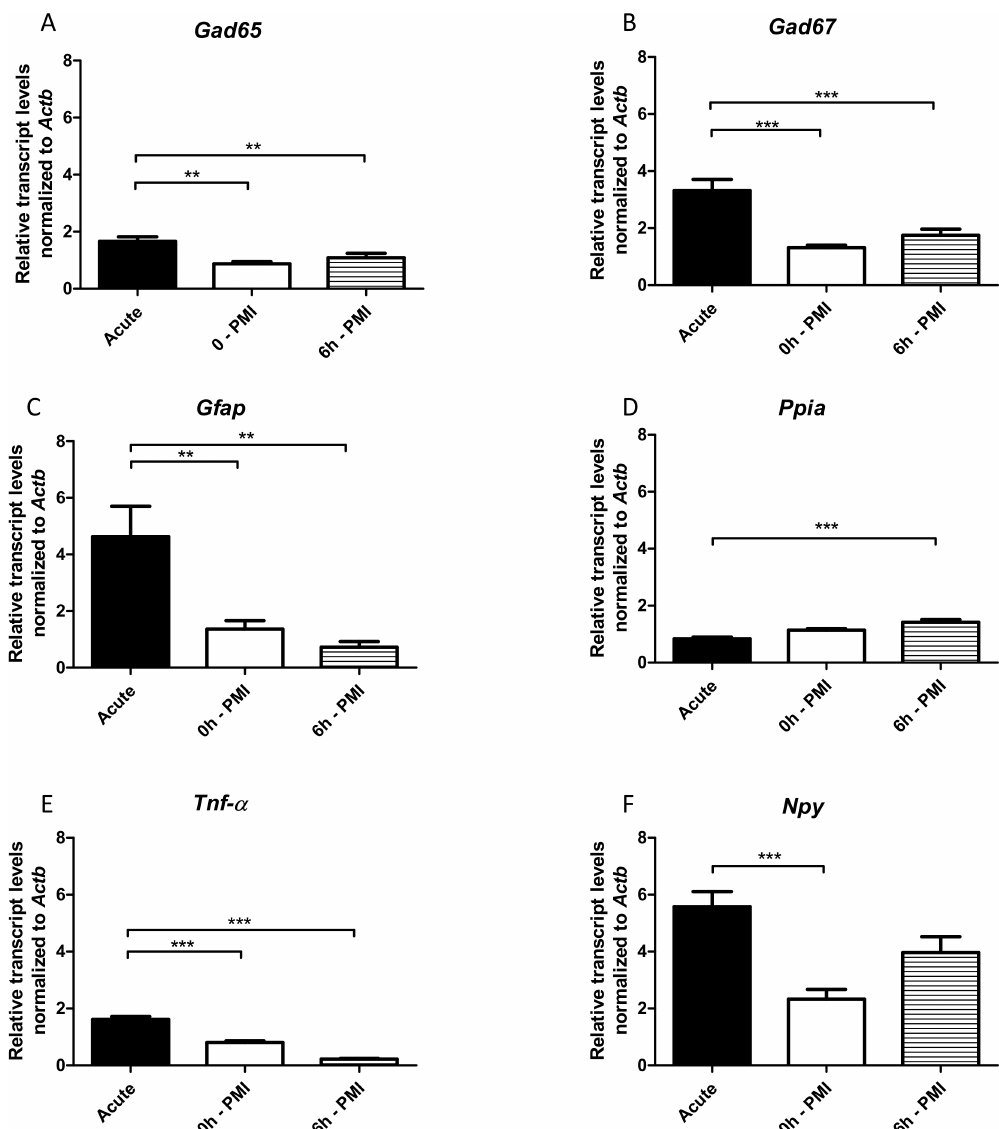
Fig 3. Hippocampal relative expressionof Gad65 , Gad67 , Gfap , Tnf- α , Npy and Ppia genes in acute-SE group compared with 0h and 6h postmortem intervals. Values are mean ± SEM, n = 6 per group, ANOVA with Bonferroni post hoc, * p < 0.05, ** p < 0.01, *** p <